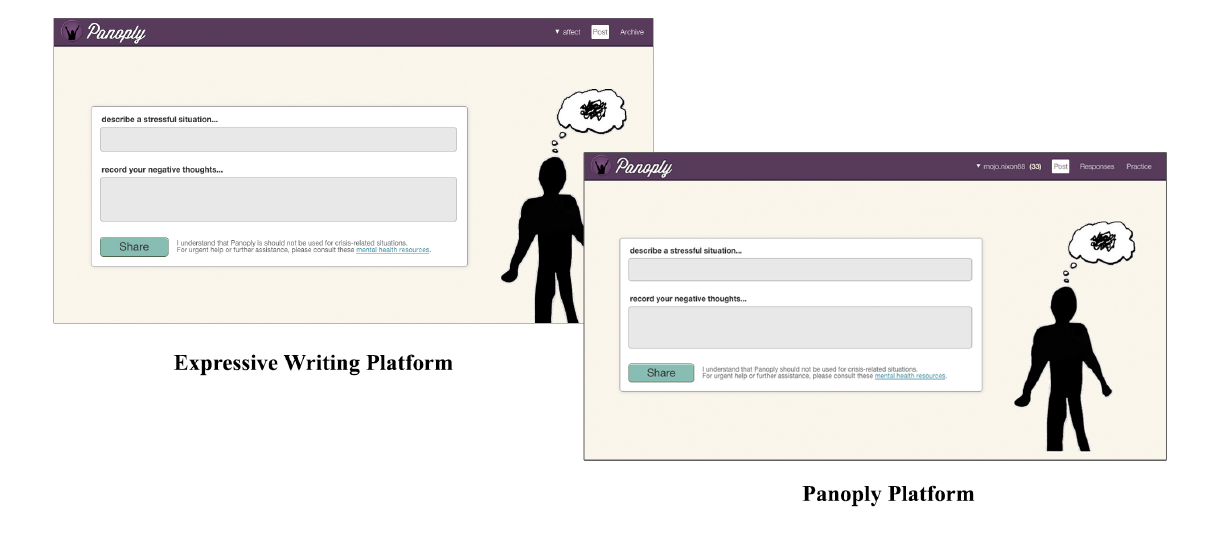
Figure 4. The control and treatment platforms were matched on non-specific factors, including visual design, user interface design, and